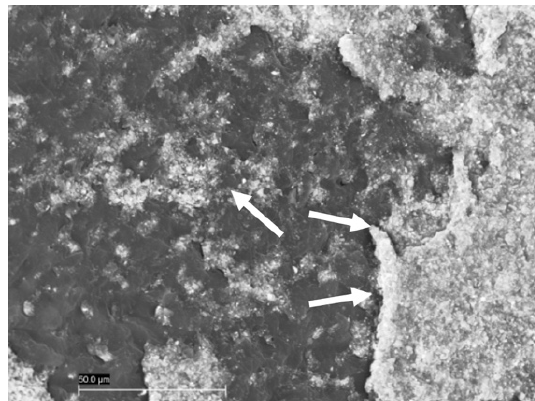
It is possible to see the OIL on the tooth surface and the material impression bonds on it.